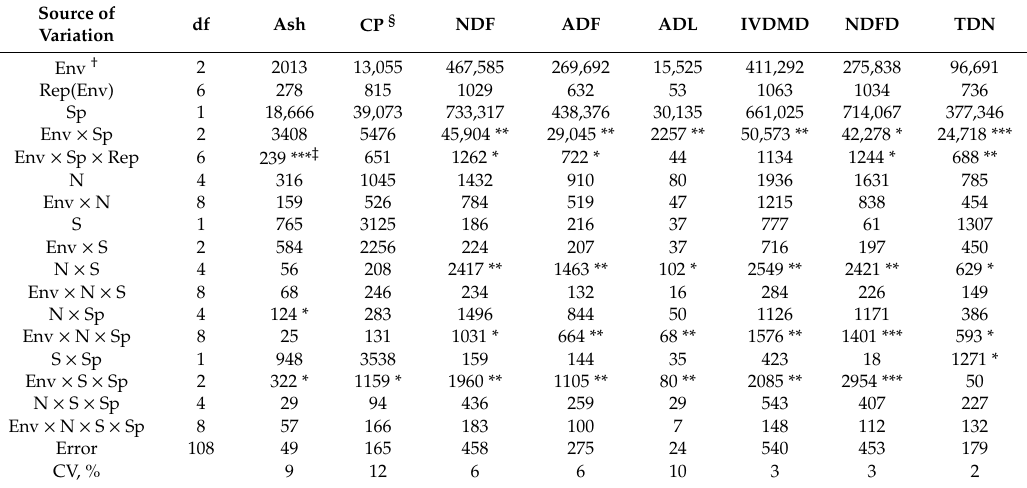
Table 9. Analysis of variance and mean squares of forage quality components of brassica root / stem for nitrogen (N) and sulfur (S) fertility in Prosper 2012 and 2014, and in Walcott, ND, USA in 2014. Source of Variation